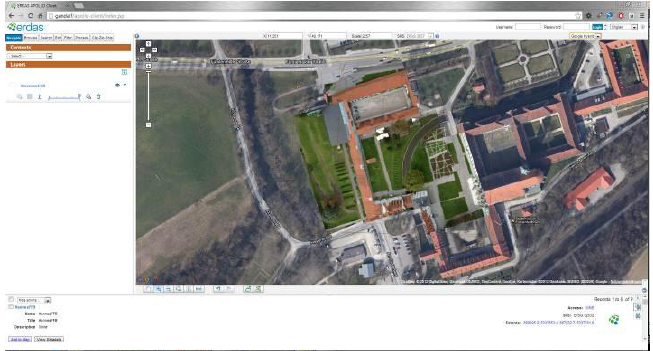
Figure 8: Georeferenced images from an octocopter flight as OGC-web